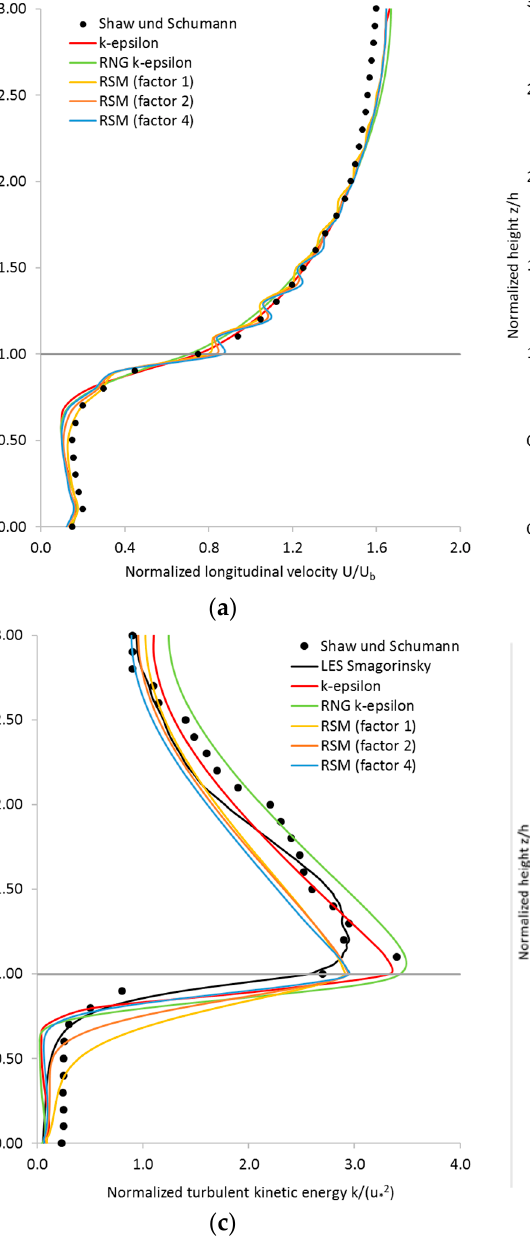
Figure 2. ( a ) Normalized longitudinal velocity, original mesh; ( b ) normalized longitudinal velocity, refined mesh; ( c ) normalized turbulent kinetic energy, refined mesh; ( d ) normalized Reynolds stress, refined mesh.